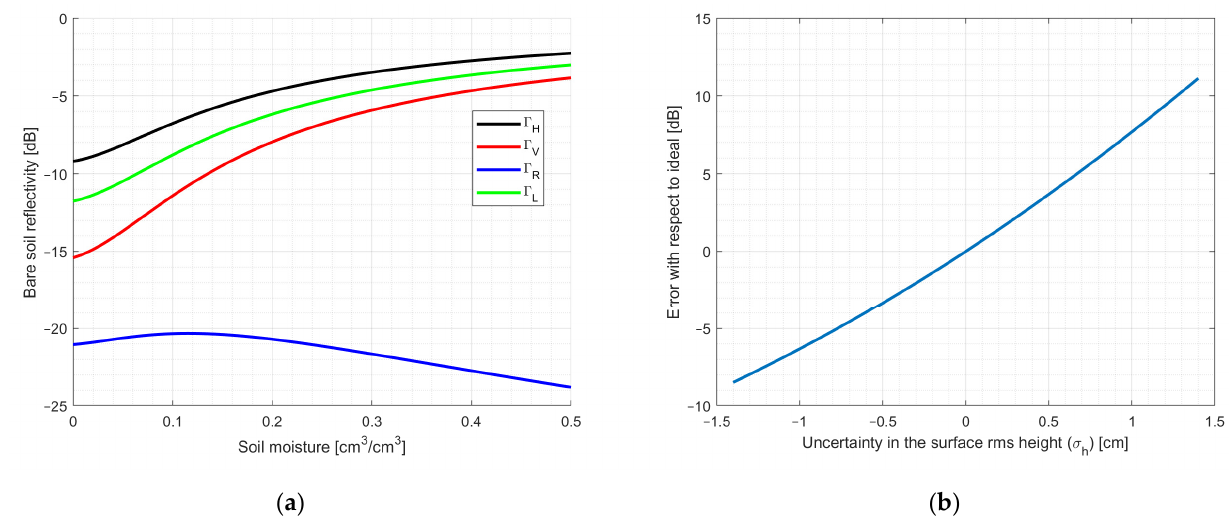
Figure 5. ( a ) Soil moisture and bare soil reflectivity fitting function simulated from a soil composition of Sand = 40%, Clay = 20%, and Silt = 60% [30] at an incidence angle of 40°, ( b ) error in the estimation of the bare soil re fl ectivity as a function of the error in the rms height. A surface roughness uncertainty of 0.8 cm (the standard deviation of the fi t from